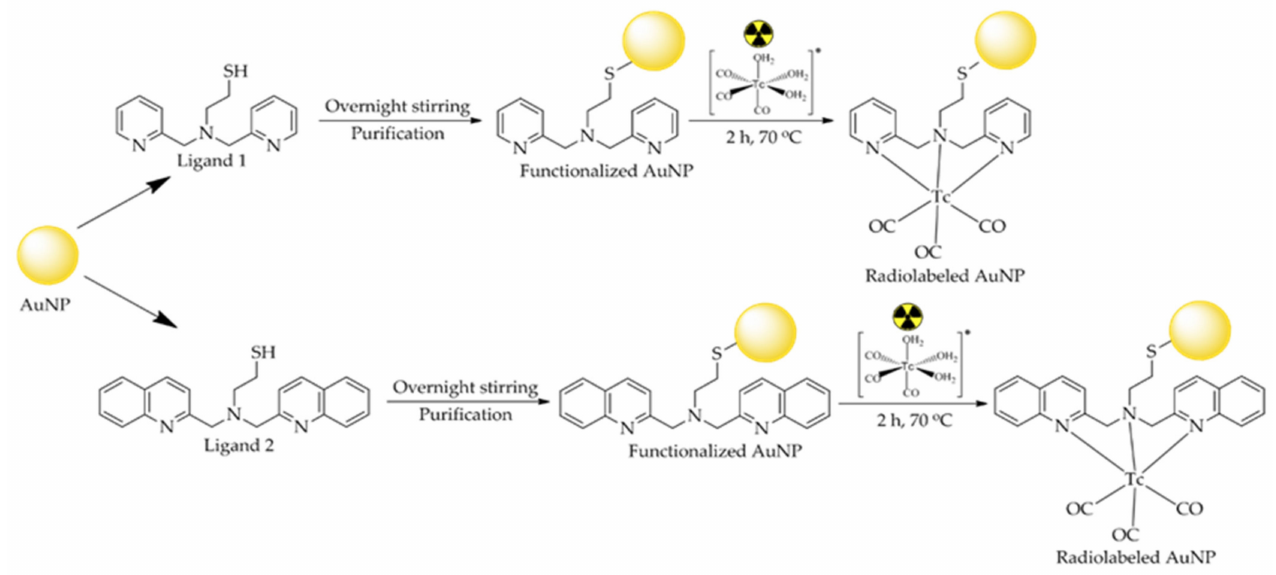
Figure 3. Functionalization of AuNPs with thiol ligands and radiolabeling with [ 99m Tc][Tc(H 2 O) 3 (CO) 3 ] +